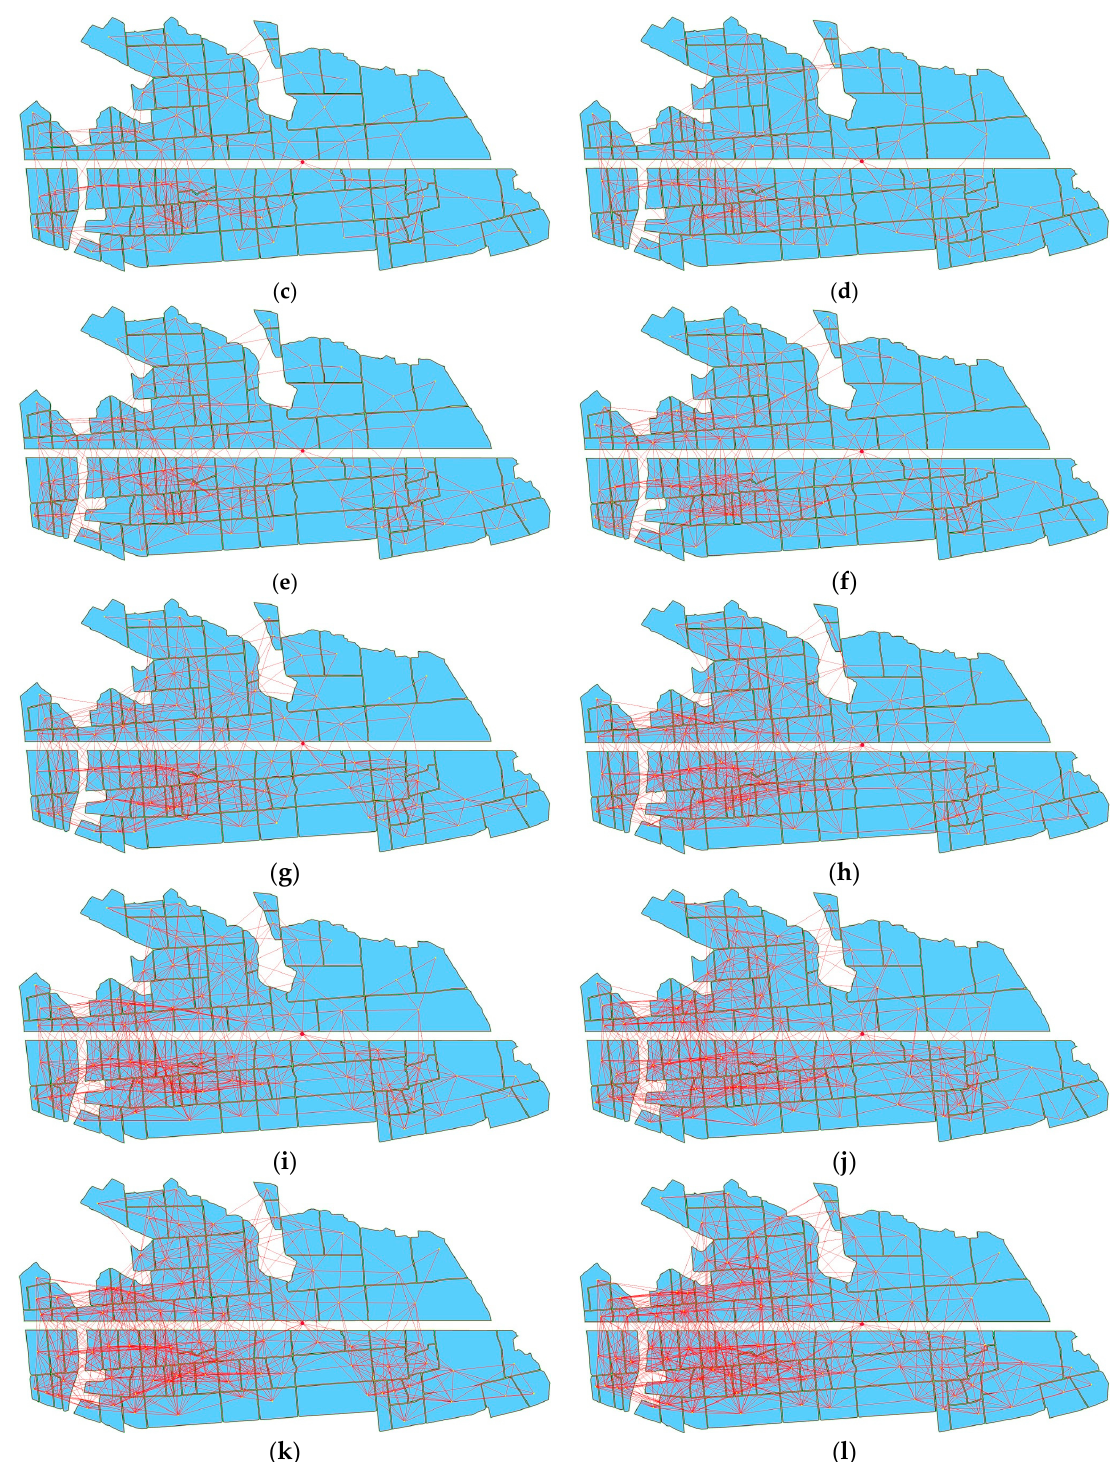
Figure 18. The WSNs deployed using method of this paper for different values of d . ( a ) d = 140 m; ( b ) d = 150 m; ( c ) d = 160 m; ( d ) d = 170 m; ( e ) d = 180 m; ( f ) d = 190 m; ( g ) d = 200 m; ( h ) d = 210 m; ( i ) d = 220 m; ( j ) d = 230 m; ( k ) d = 240 m; ( l ) d = 250 m.